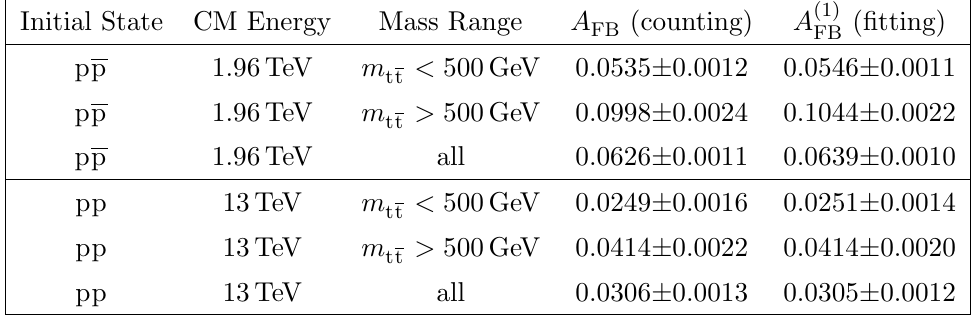
is assessed by comparing FB and of event counting to determine A . The pp FB FB